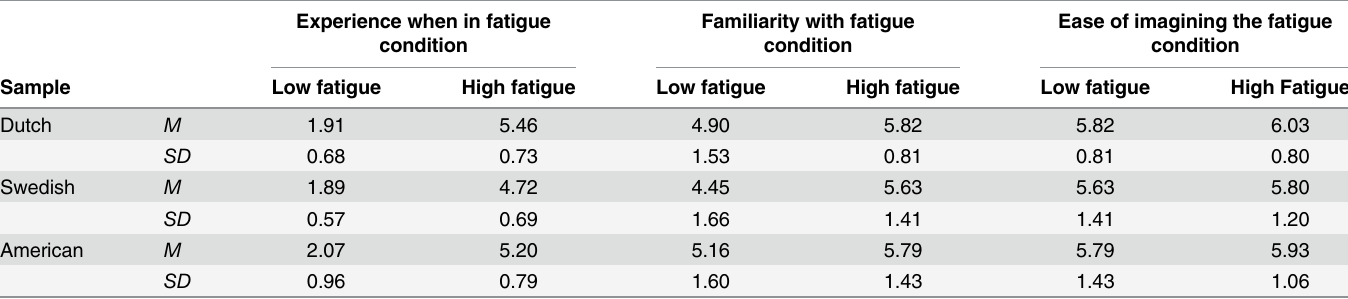
Table 2. Descriptive statistics (means and standard deviations) for the checks on the fatigue manipulation, broken out by sample country.